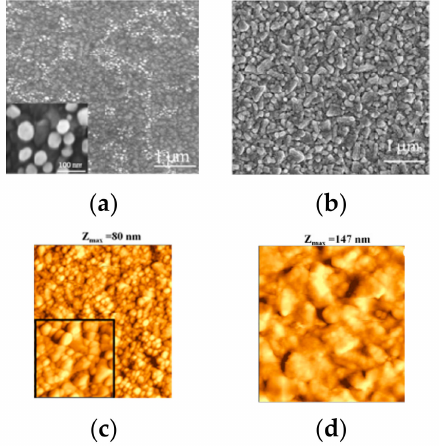
Figure 2. ( a , b ) Plan-view SEM image of ( a ) gold nanoparticles counter-electrode deposited by chemical reduction, and ( b ) gold film counter-electrode deposited by thermal evaporation. ( c , d ) 2 µ m × 2 µ m AFM images of the samples deposited by ( c ) chemical reduction, ( d ) thermal evaporation. In ( c ) the inset is 0.5 µ m × 0.5 µ m AFM scan of the corresponding sample. Figure 3. Distribution of the diameters D of the Au nanoparticles in the samples deposited by chem- ical reduction. The continuous line is the Gaussian fits of the experimental data.